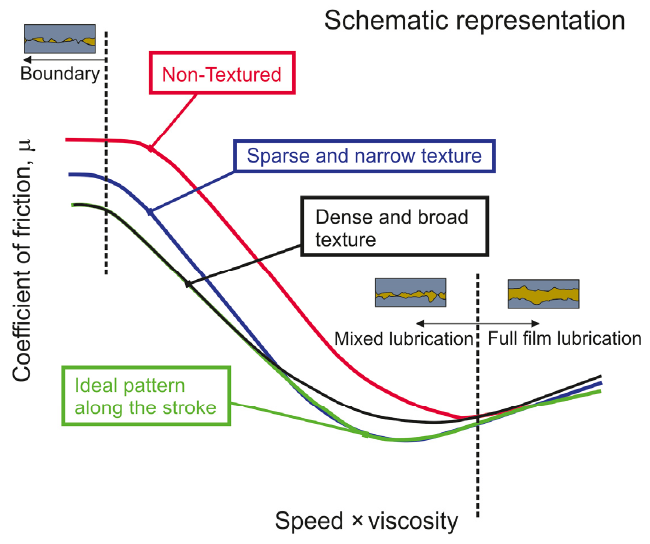
Figure 8. Scheme of criteria for varying the pocket pattern along the stroke, after [76].